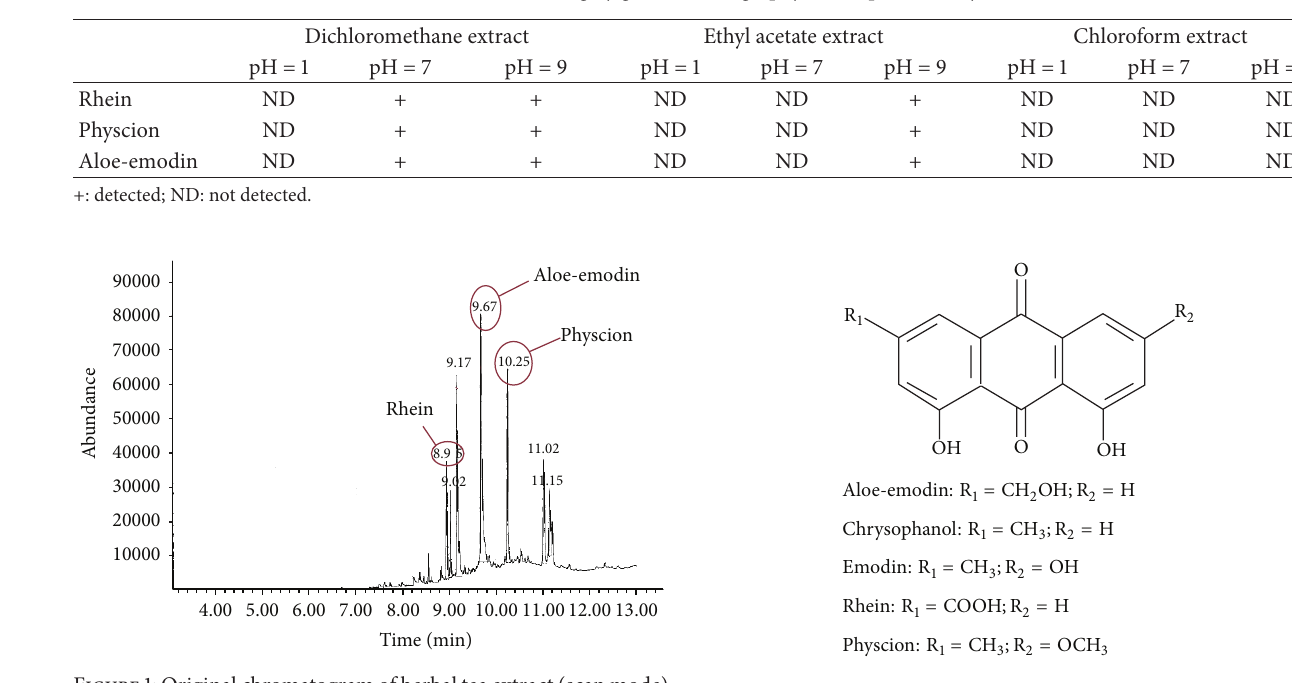
Figure 1: Original chromatogram of herbal tea extract (scan mode). Figure 2: Chemical structure of anthraquinone glycosides